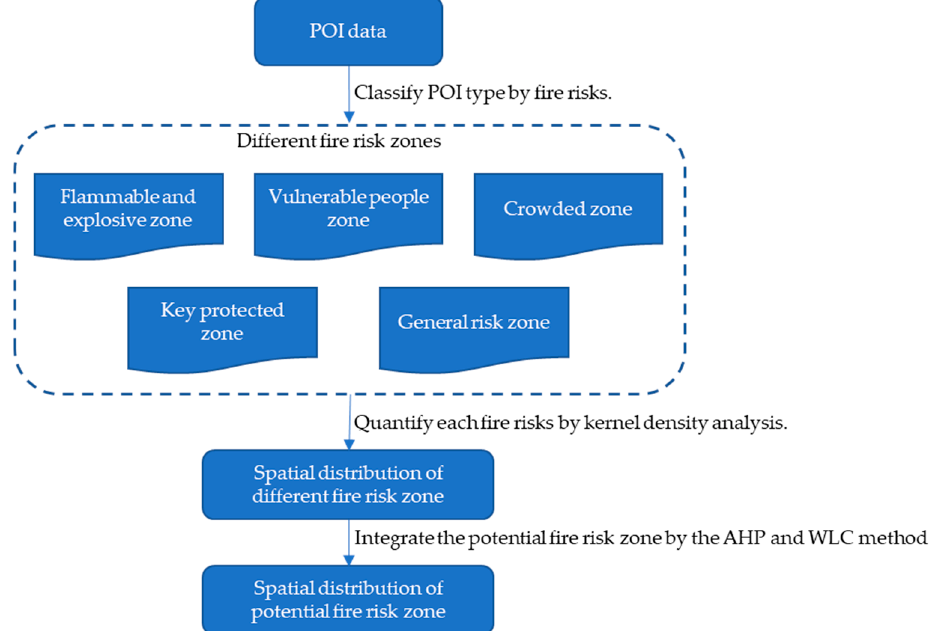
Figure 3. Framework of method for identifying fire-risk zones.